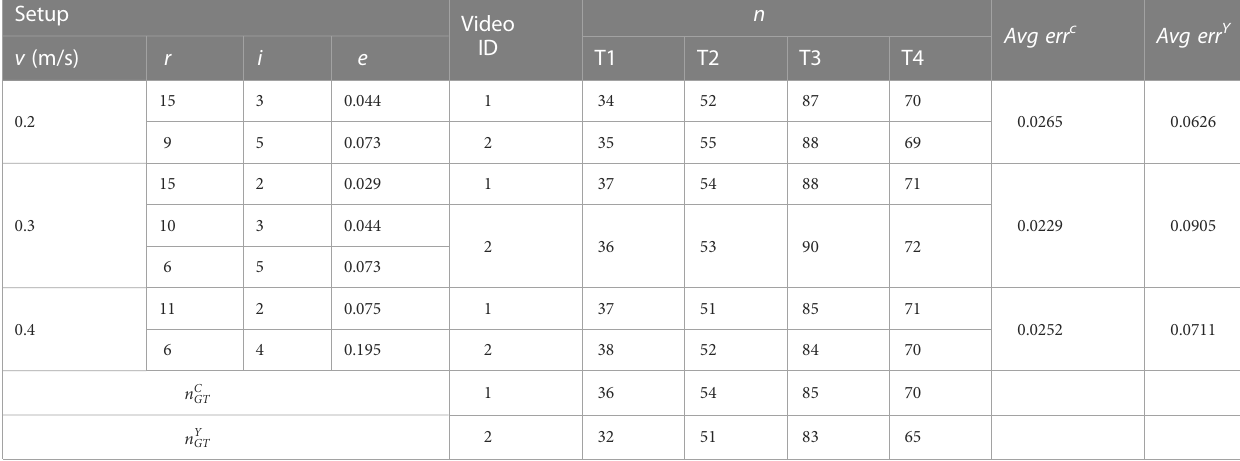
TABLE 5 Yield monitoring performance comparison at various speeds of MRP. Setup